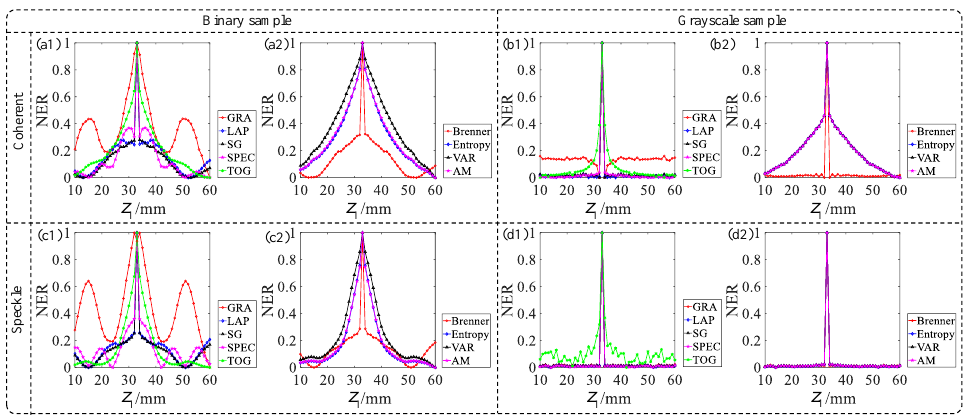
Figure 7. The performance of autofocus by coherent illumination and speckle illumination, respec- tively: ( a1 , a2 , b1 , b2 ) show the CEF curves of binary and grayscale sample respectively by using diffraction patterns; ( c1 , c2 , d1 , d2 ) show the CEF curves of binary and grayscale sample respectively by using speckle